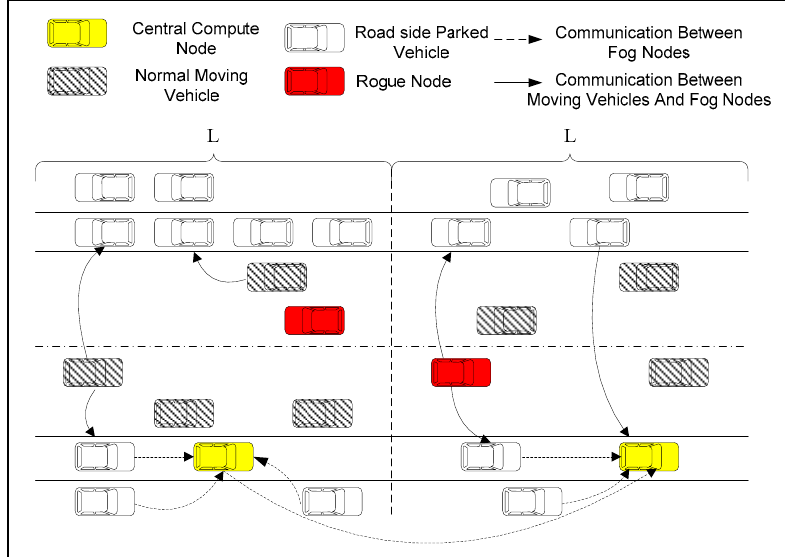
Figure 1. Basic network architecture.